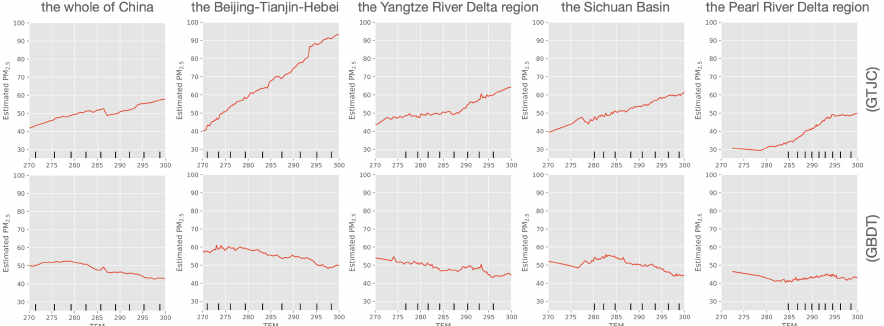
Figure 6. the one-way partial dependence plots (PDP) of temperature (TEM) of GBDT model and GTJC model. The black bars on the axes show the deciles of the feature values in the training